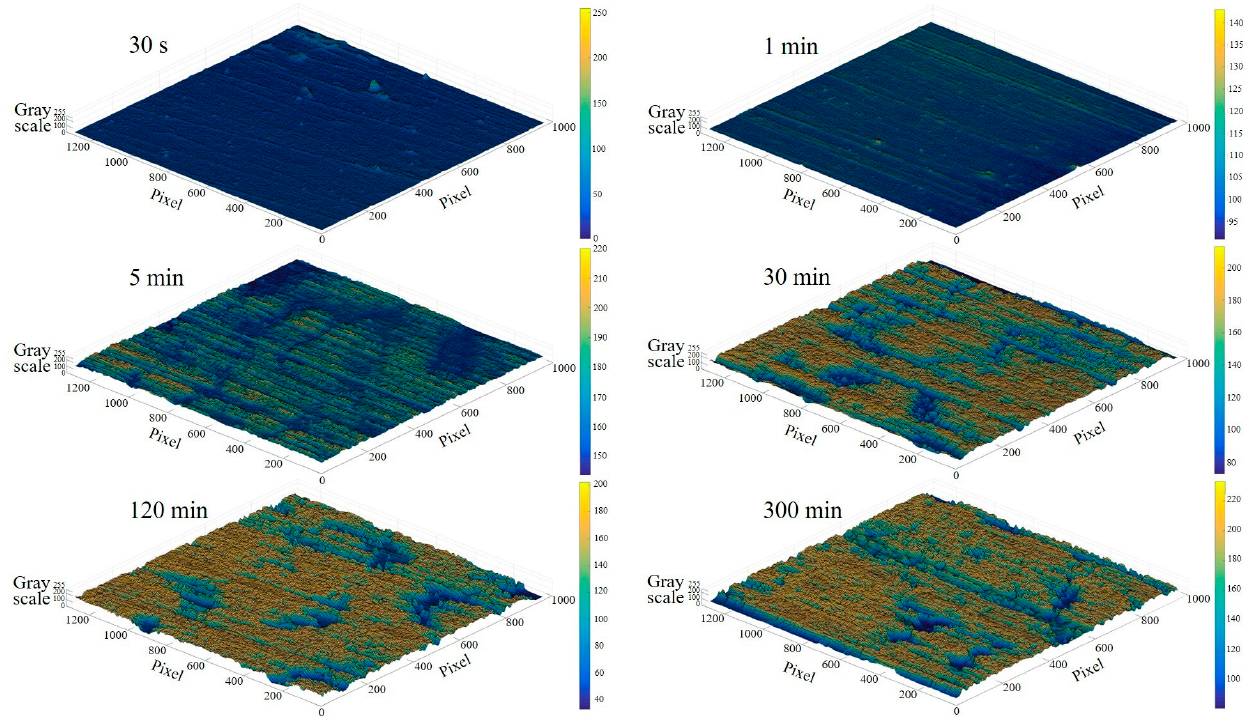
Figure 4. Grey scale diagram of the transfer film at different friction stages.